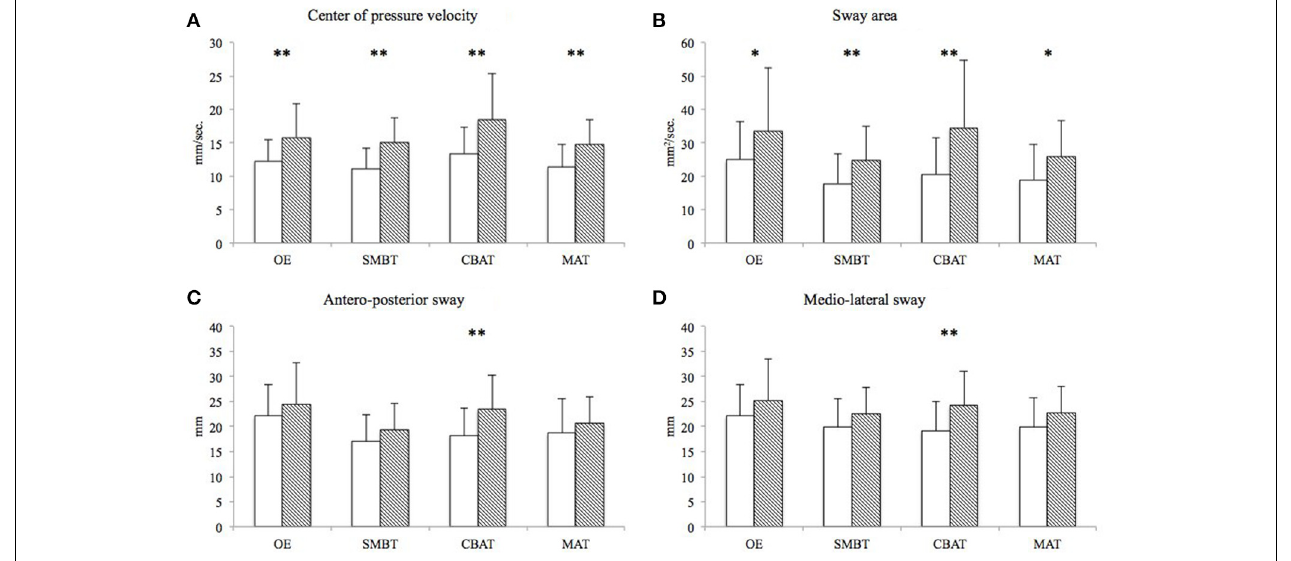
indicate a statistically significant difference between young and elderly participants. CoPV, center of pressure velocity; SA, sway area; AP, antero- posterior sway; ML sways, medio-lateral sway; mm, millimeter; s,